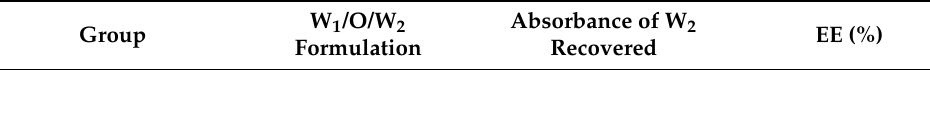
Table A6. Determination of the encapsulation efficiency